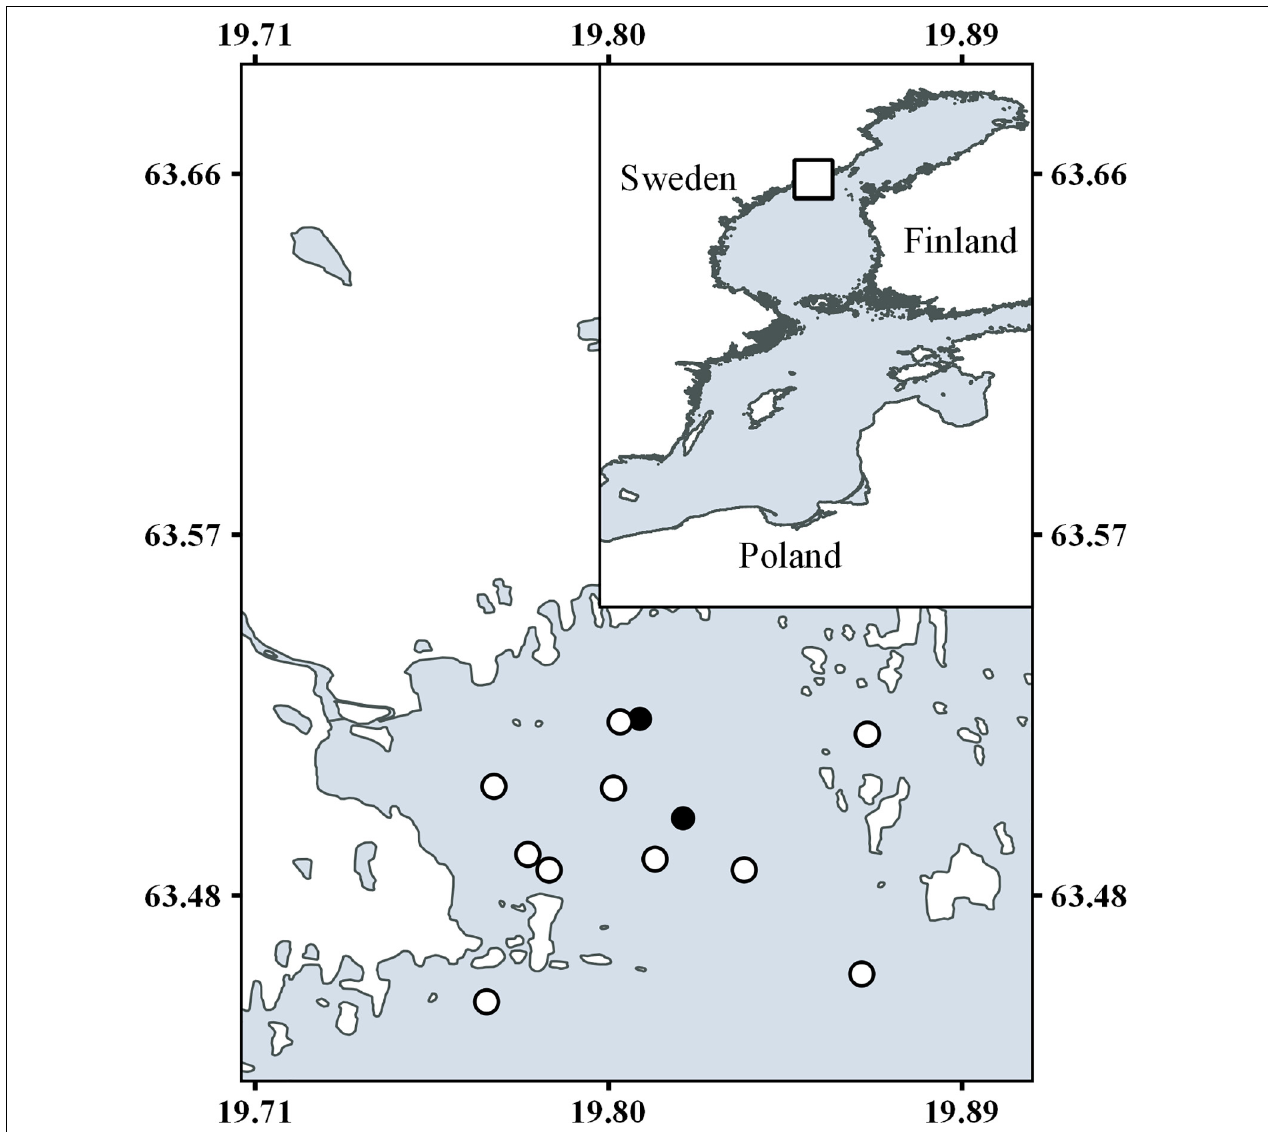
FIGURE 1 | Map of the Öre estuary and sampling stations. Filled circles show the environmental monitoring stations B7 and B3 used for the majority of measurements. Open circles show the stations for the nitrification measurements. The insert show an overview of the Baltic